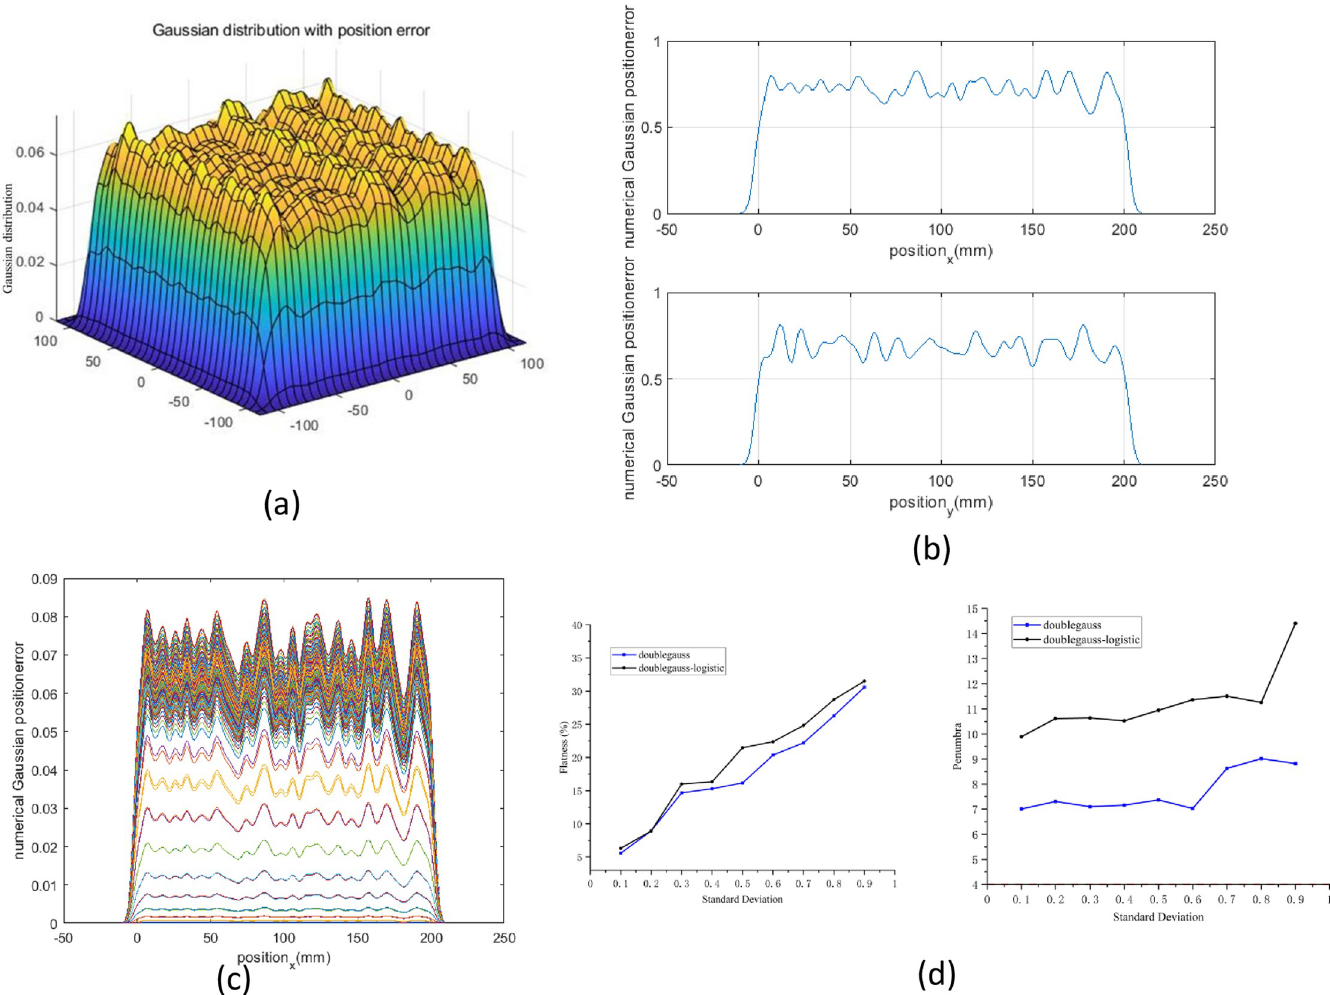
Fig 10. The influence of spot position error on flatness and penumbra. (a) 3D Gaussian distribution with beam spot position error was plotted by MATLAB. (b) and (c) The projection of Gaussian distribution was drawn in both x- and y-directions. (d) The calculated flatness and penumbra were compared in the standard Gaussian model and the double Gaussian-logistic model (left and right